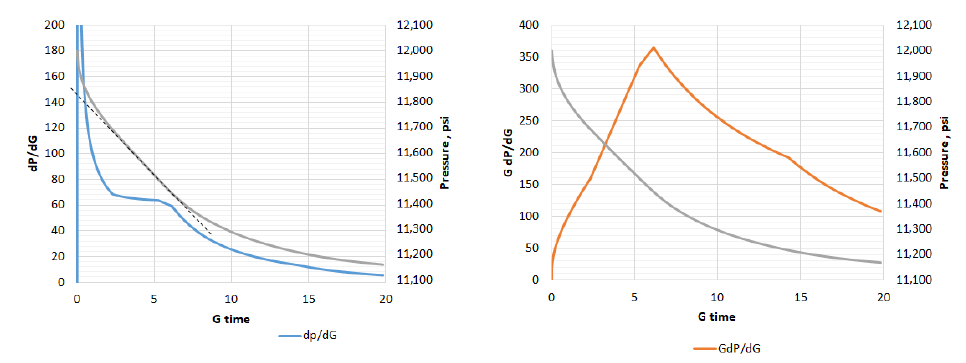
Figure 18. Tangent method (dP/dG and GdP/dG) for the synthetic reverse-calculated pressure decay